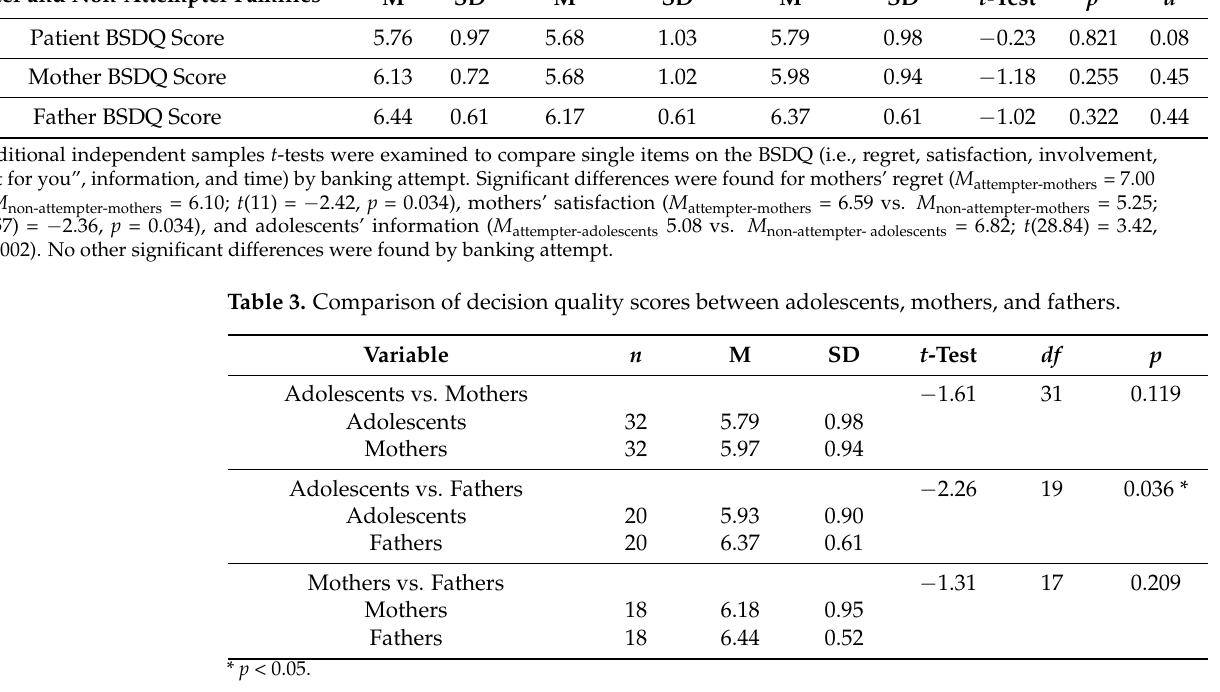
Table 2. Comparison of decision quality scores between attempter and non-attempter families. Comparison of Decision Quality Scores between Attempter and Non-Attempter Families a